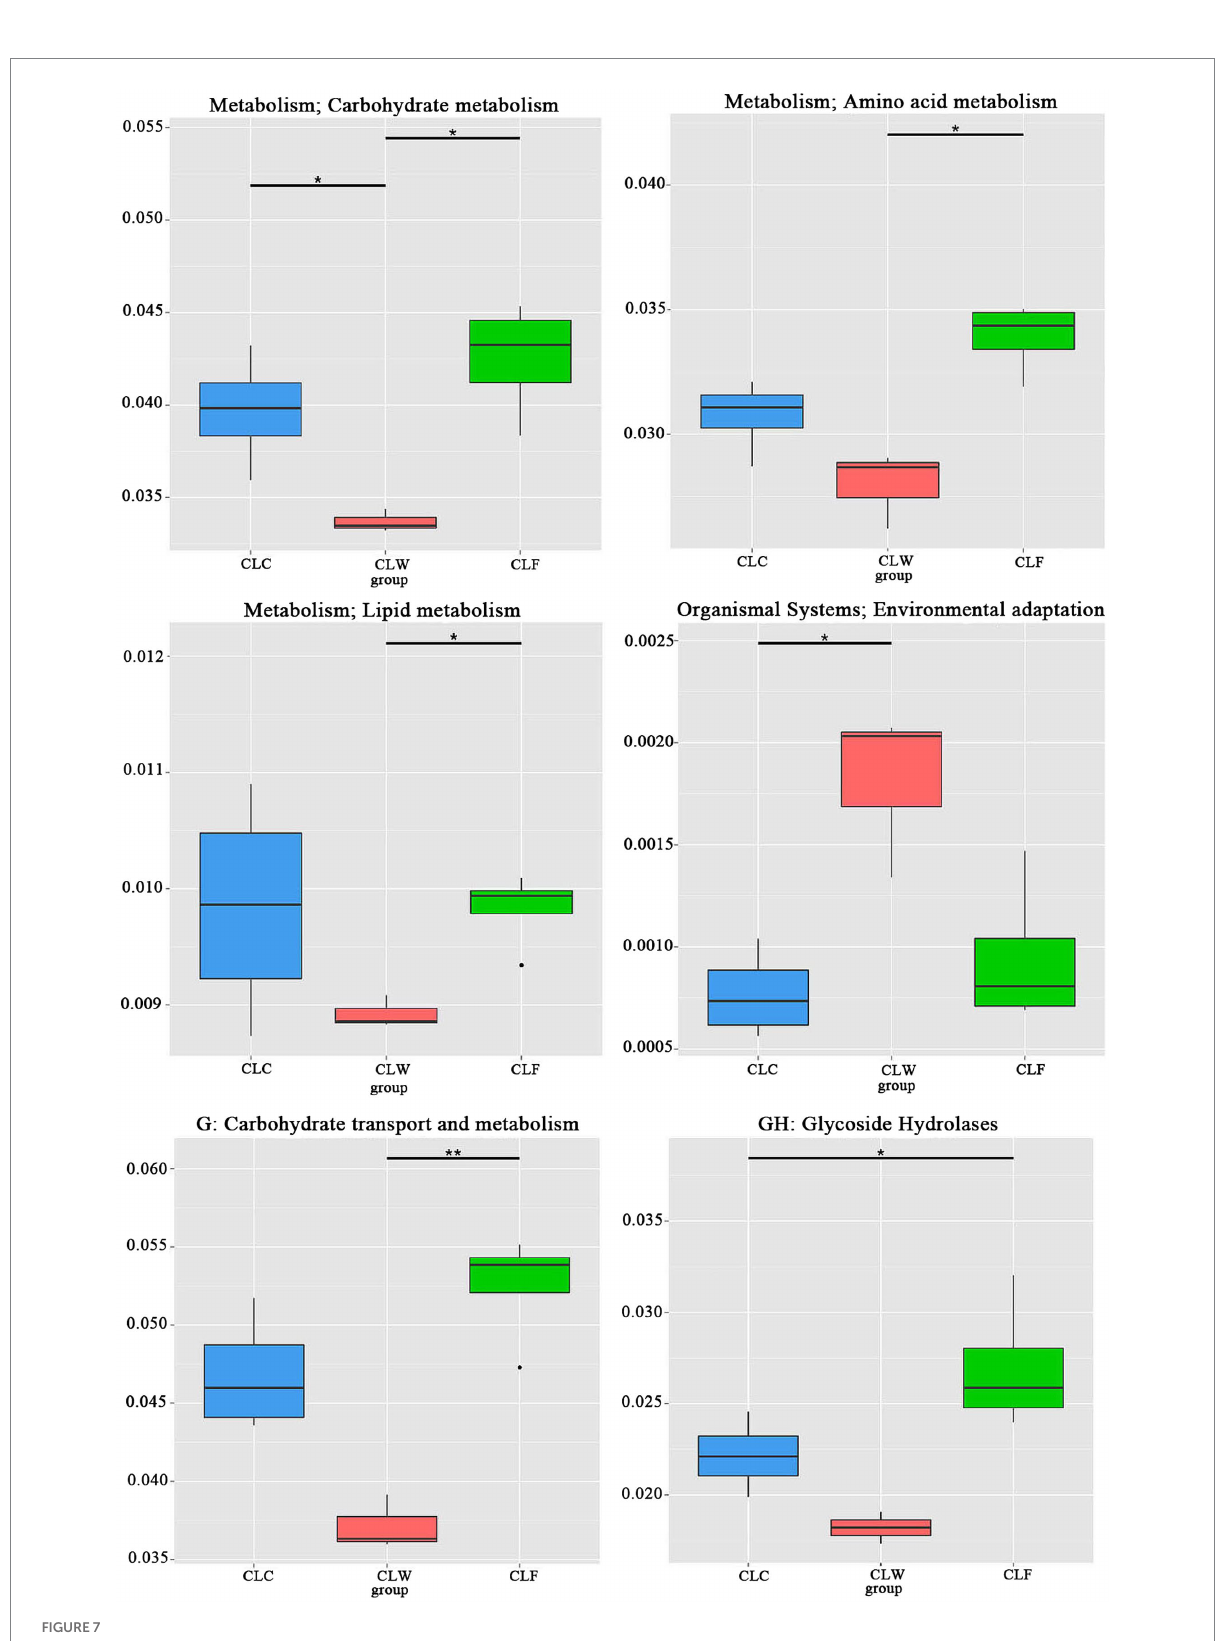
FIGURE 7 Metastat test revealed significantly difference in function abundance among groups CLW, CLC and CLF annotated at eggnog level 1. “*” represented significant difference and “**” represented extremely significant